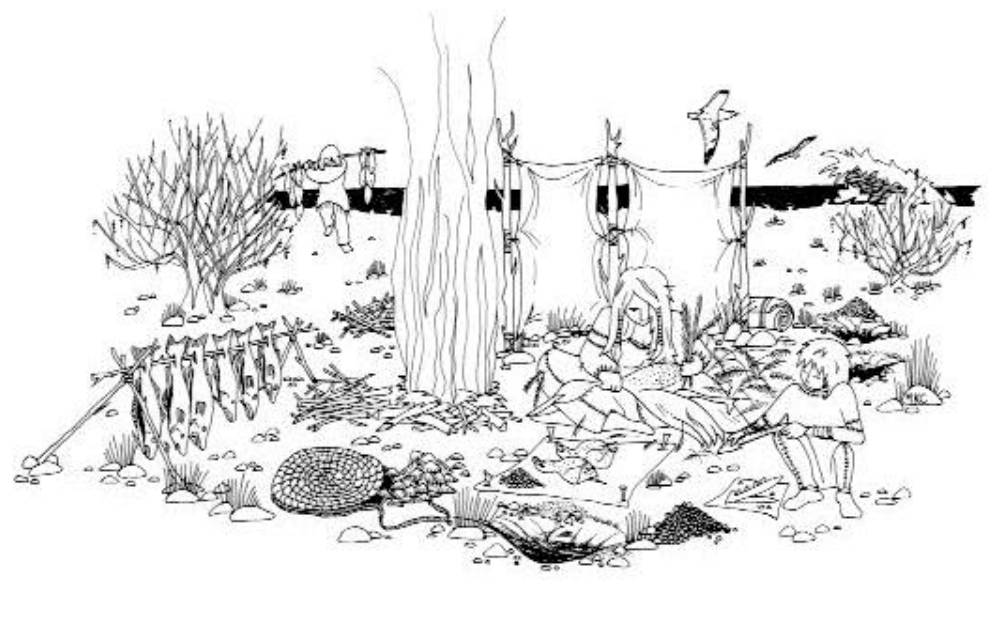
Figure 12 : Reconstruction by Mary Kemp-Clarke - a mesolithic fishers’ camp, or a bird hunters’